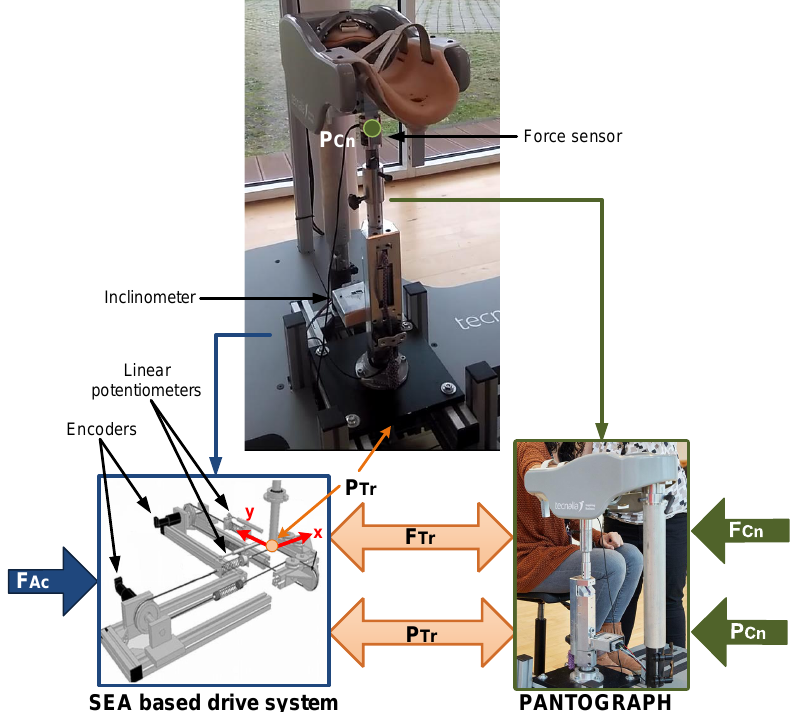
Figure 2. Two main subsystems of the UHP rehabilitation